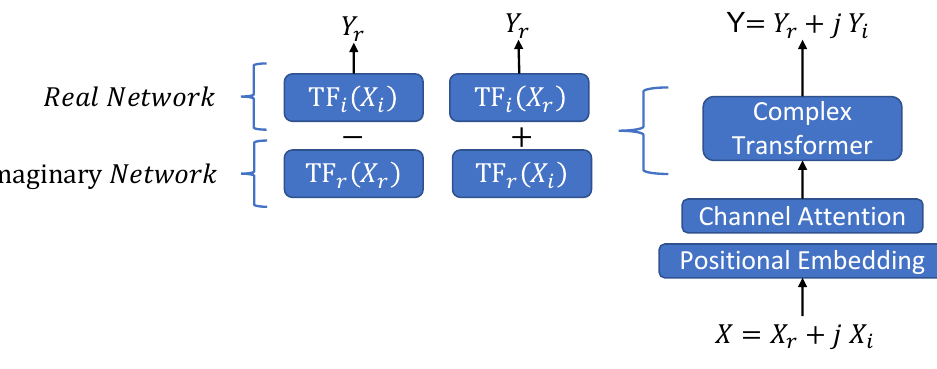
Figure 3. Complex transformer